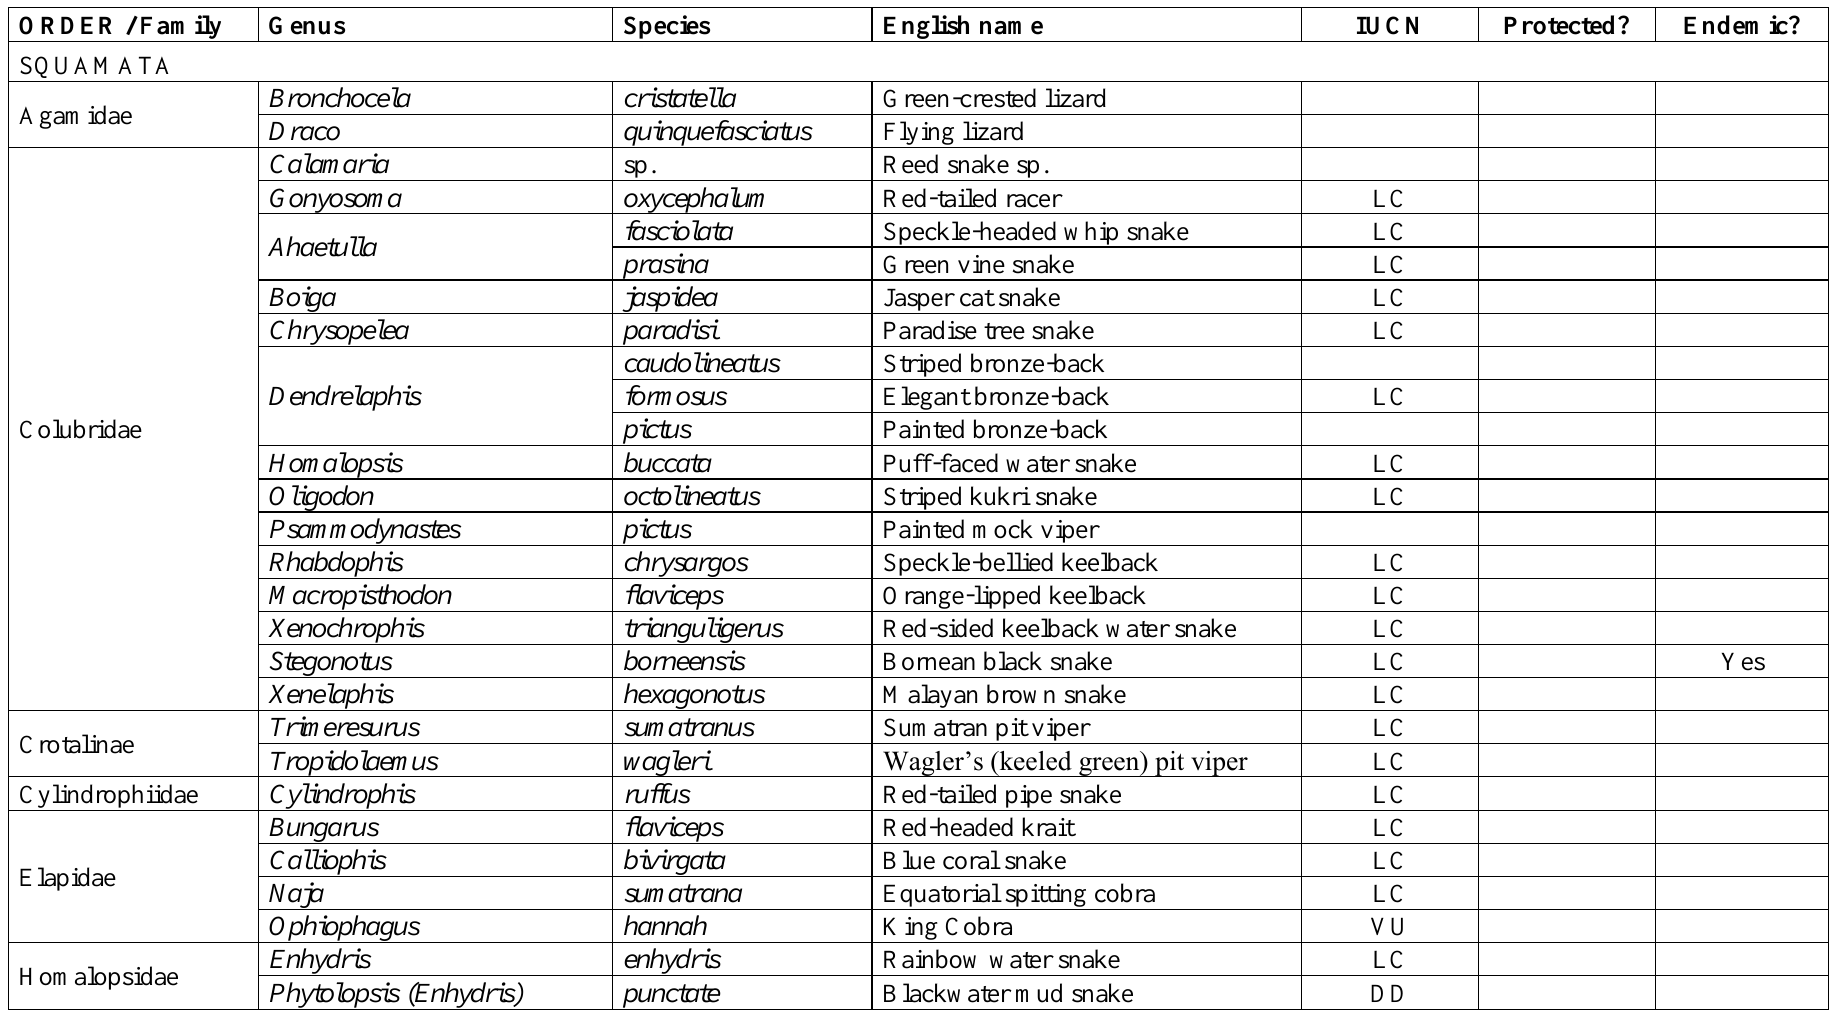
Table A8. List of reptile (Reptilia) species recorded in the NLPSF, Sebangau, together with IUCN Red List classifications (DD = data deficient; EN = endangered; LC = least concern; NT = near threatened; VU = vulnerable), Indonesian protected species listings (i.e. ‘Protected?’ refers to protection status in Indonesia) and Borneo endemic species assignments. Parentheses indicate synonyms and slashes indicate cases in which identification between two classifications is uncertain. ORDER /